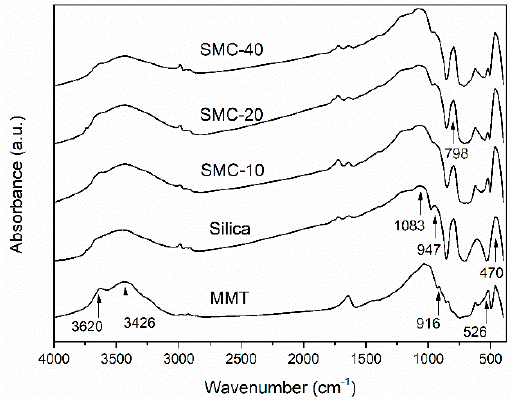
Figure 1. Fourier transform infrared spectra (FTIR) spectra of montmorillonite (MMT), silica and silica/MMT nanocomposites.